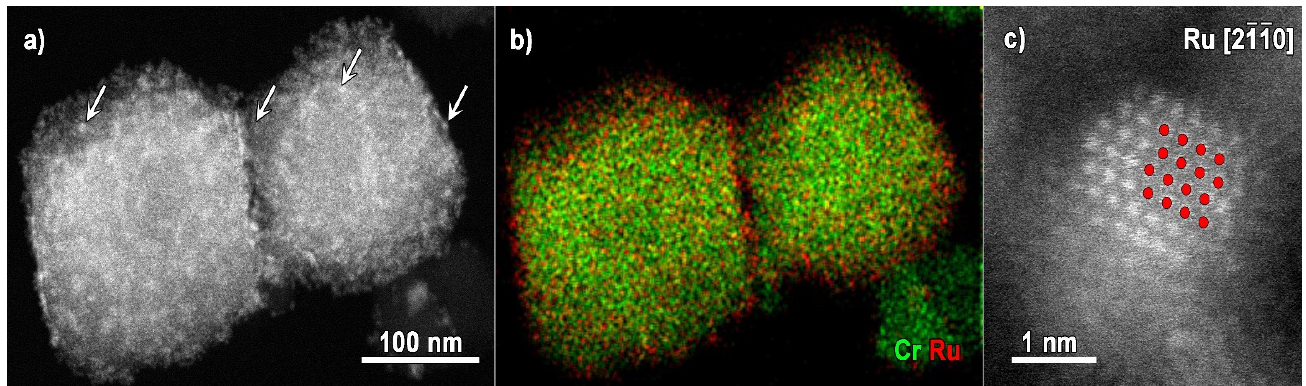
Figure 1. ( a ) Overview ADF STEM image of Ru@MIL-101 particles and ( b ) corresponding EDX map for Cr and Ru, ( c ) ADF-STEM image of a Ru nanoparticle taken along the [ 2110 ] zone axis with Ru (Ru shown in red) structural model viewed along the [ 2110 ] zone axis.